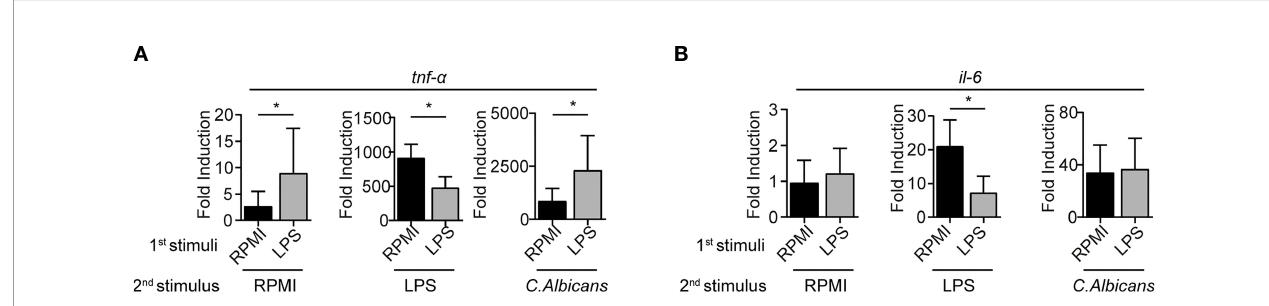
FIGURE 3 | mRNA cytokine expression levels are impaired in LPS-primed BMMCs. mRNA expression of TNF- a (A) and IL-6 (B) were measured by rt-PCR on LPS-primed BMMC after 3 hours of stimulation with LPS (1mg/ml), live C. Albicans (MOI=1) or RPMI. Data are expressed as mean +SD from n=3 experiments. Statistical analysis were performed with paired Student t-test (*p <